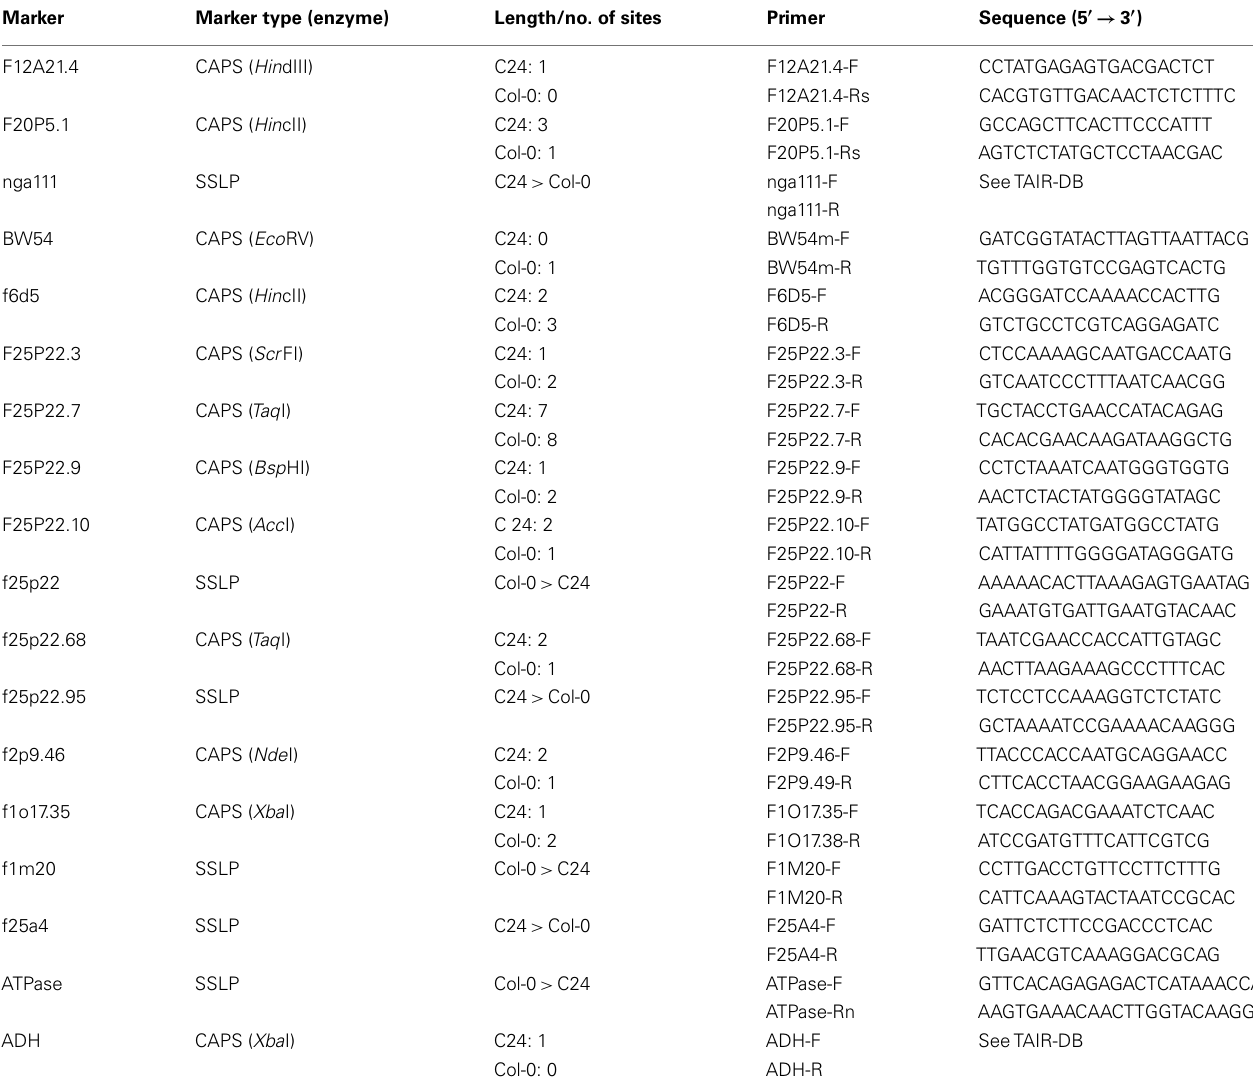
TableA1 | Markers around RSR1 on chromosome I to distinguish between Col-8 and C24